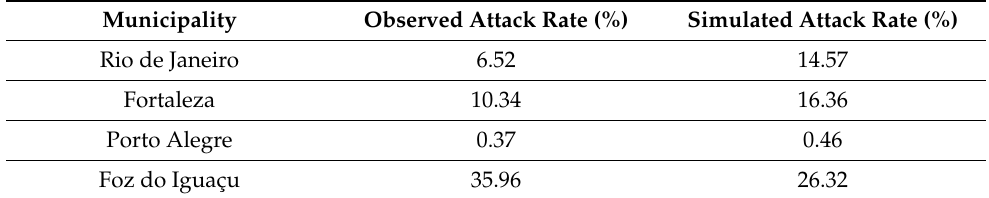
Figure 4. Observed (black dots) and simulated (red line) dengue incidence time series for the four studied municipalities. Table 5 indicates the attack rates for each municipality, i.e., the sum of all infected individuals during the period divided by the size of the population at risk. This differed between the simulated and observed time series. Foz do Iguaçu presents a lower simulated attack rate than the observed (9.64% difference), while epidemic overestimation in 8.05%, 6.02% and 0.09% were observed for Rio de Janeiro, Fortaleza and Porto Alegre respectively. Table 5. Observed and simulated attack rates (%) by